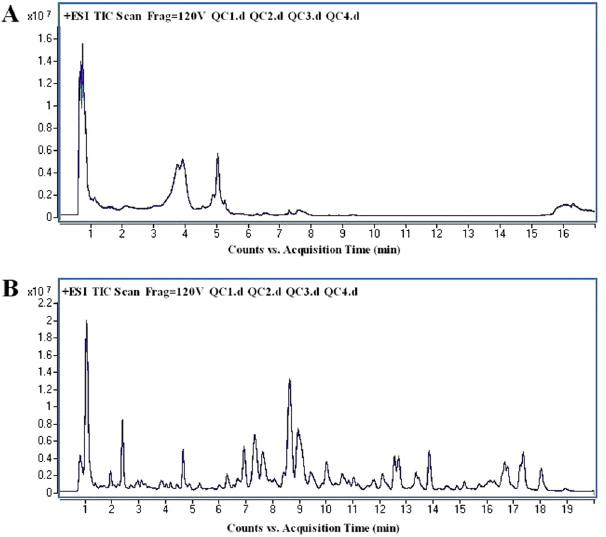
Figure 2. The overlapped total ion chromatography (TIC) of 4 QC samples in positive ion mode in both ( A ) metabolomic analysis and ( B ) lipidomic analysis.